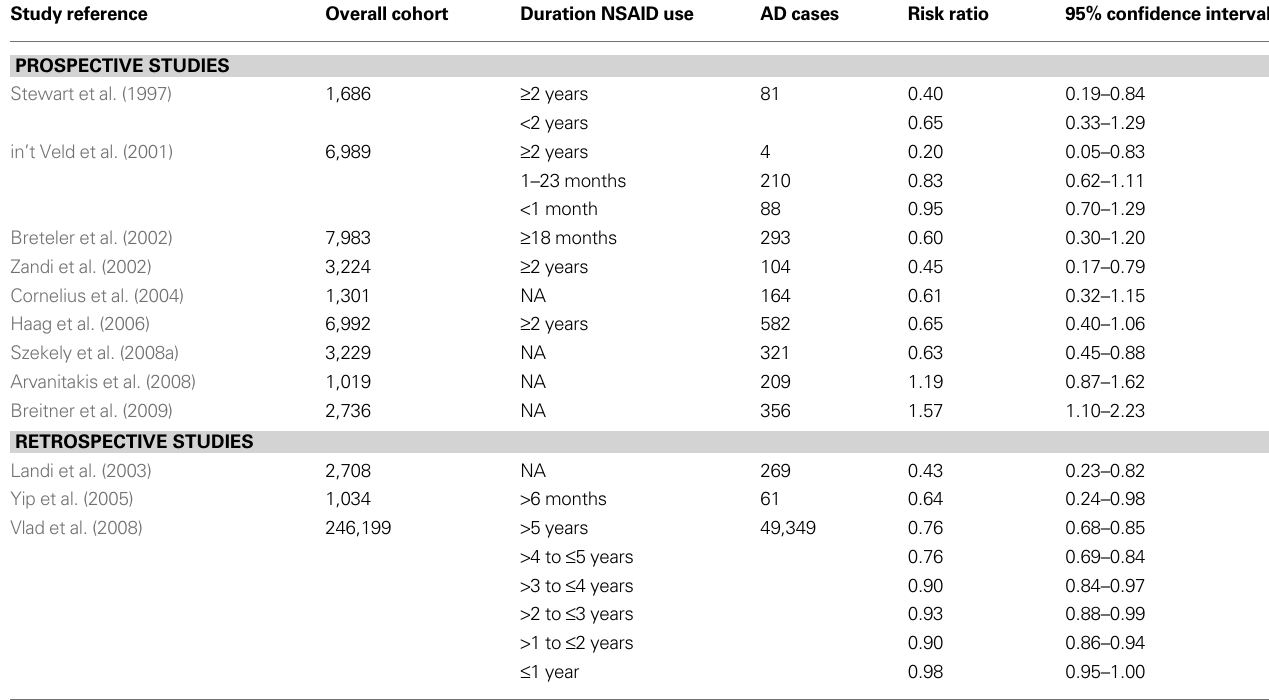
Table 1 | Summary of the main prospective and retrospective epidemiological studies of NSAIDs and AD. Study